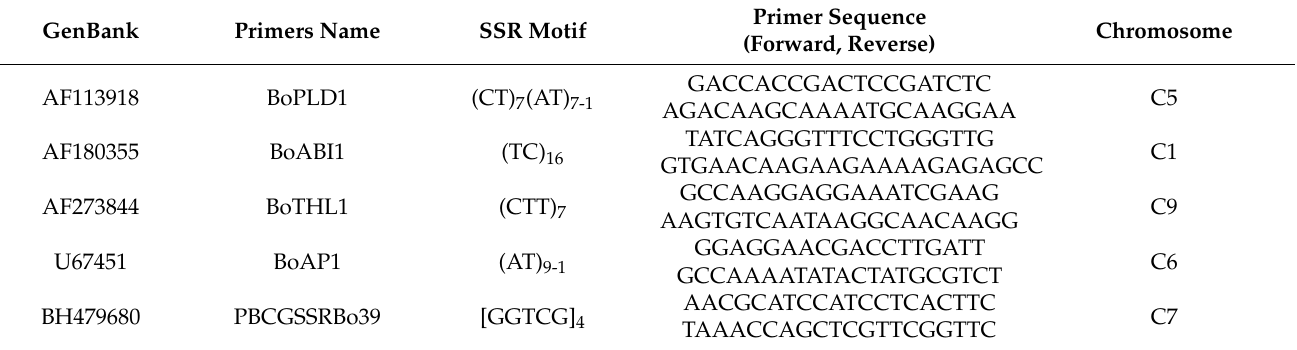
Table 2. List of primers utilized with their sequences and chromosome